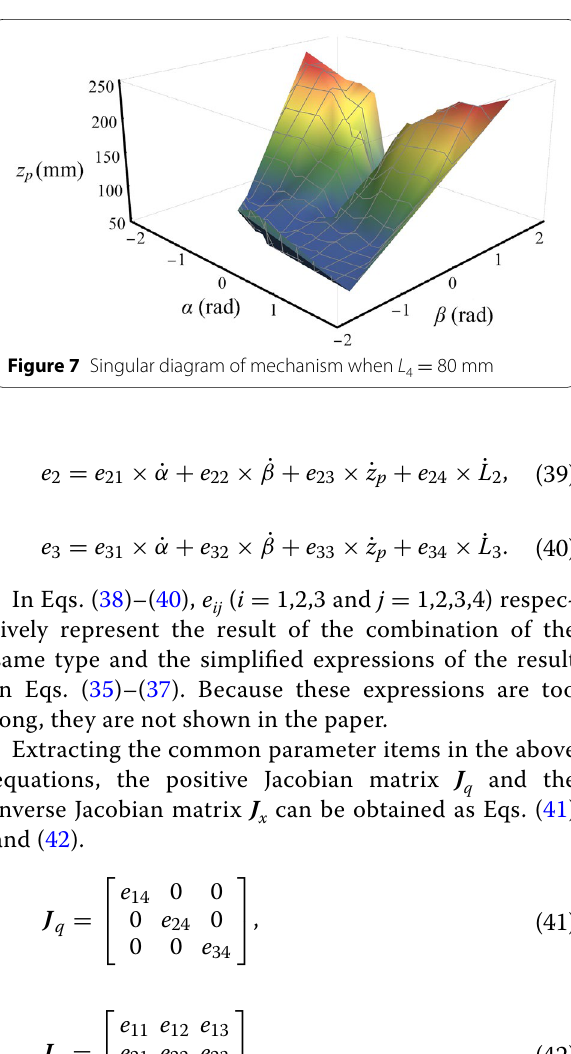
Figure 7 Singular diagram of mechanism when L 4